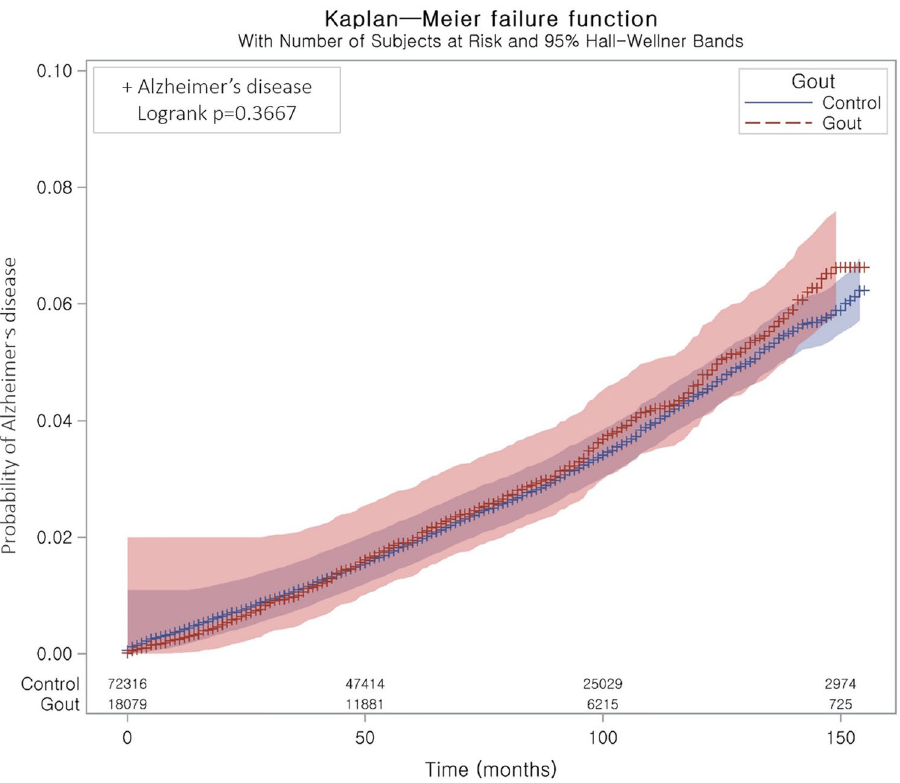
Figure 1. Kaplan ‒ Meier probability of the incidence of Alzheimer’s disease in gout and the control participants within 13 years of the index